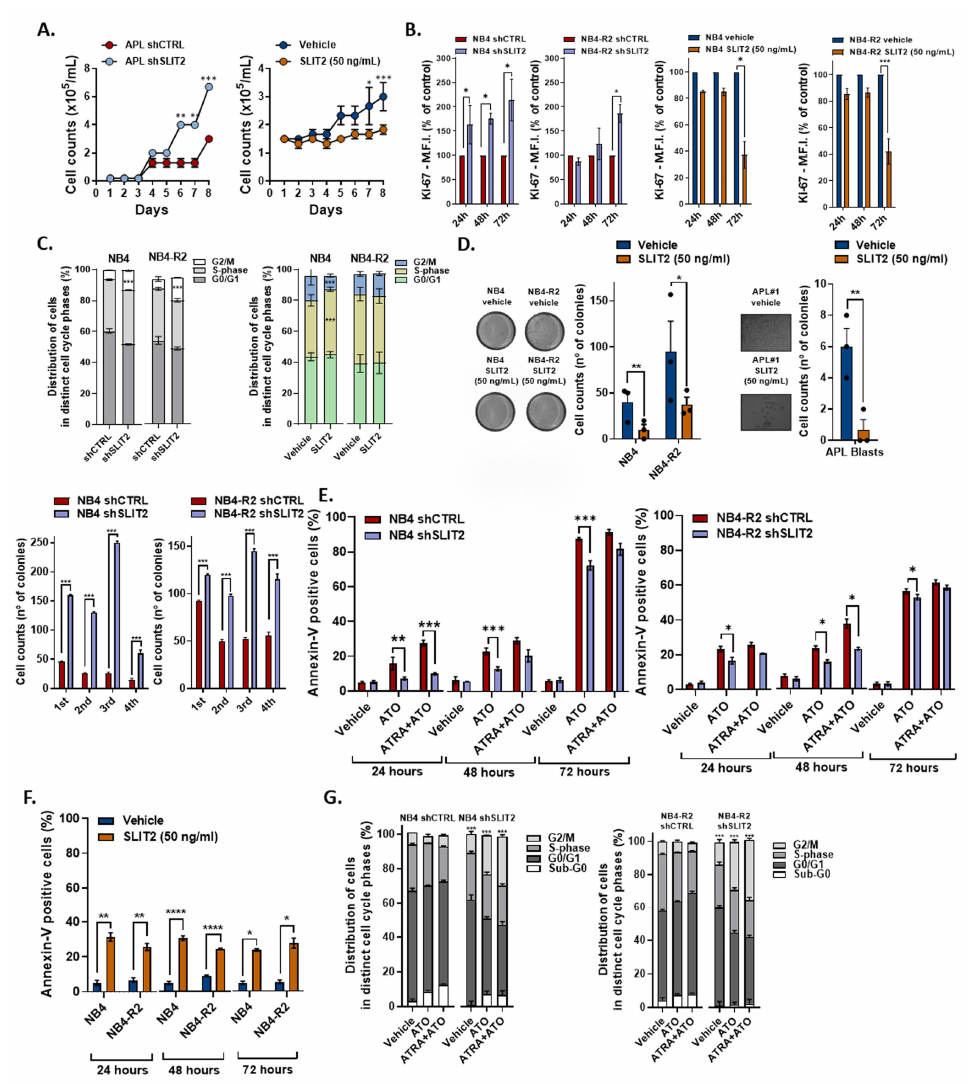
Figure 2. Effect of SLIT2 on APL cell proliferation. ( A ) Growth curves using human primary blasts from APL patients, transduced with shSLIT2 or scrambled control (shCTRL) (left panel), and treated with SLIT2 peptide (50 ng/mL) (right panel). ( B ) Ki67 staining and ( C ) cell cycle analysis of NB4 and NB4-R2 cell lines transduced with shSLIT2 or scrambled (shCTRL) and wild-type NB4 and NB4-R2 cells treated with SLIT2 peptide (50 ng/mL). ( D ) Representative example of one of three independent experiments of colony formation assay in methylcellulose using wild-type NB4, NB4-R2 (left panel), and primary human APL blast cells (right panel) treated with SLIT2 peptide (50 ng/mL). Graphic bars represent the average of the number of colony-forming cells when treated. Lower panel shows the graphic bars representing the average of the number of colonies from APL cell lines (NB4 and NB4-R2) transduced with shSLIT2 and control (shCTRL). Effect of SLIT2 on drug-induced apoptosis. Percentage of apoptotic transduced cells ( E ) and SLIT2-treated cells ( F ) after 24, 48, and 72 h in culture with apoptotic stimulus. ( G ) Cell cycle analysis of NB4 and NB4-R2 cell lines transduced with shSLIT2 or scrambled (shCTRL) upon arsenic trioxide (ATO) (1 µ M) and ATO + all-trans retinoic acid (ATRA) (1 µ M each), for 24 h. Graphic bars represent the mean and standard error (SD) of four independent experiments. * indicates p < 0.05, ** indicates p < 0.01, *** indicates p < 0.001, **** indicates p <